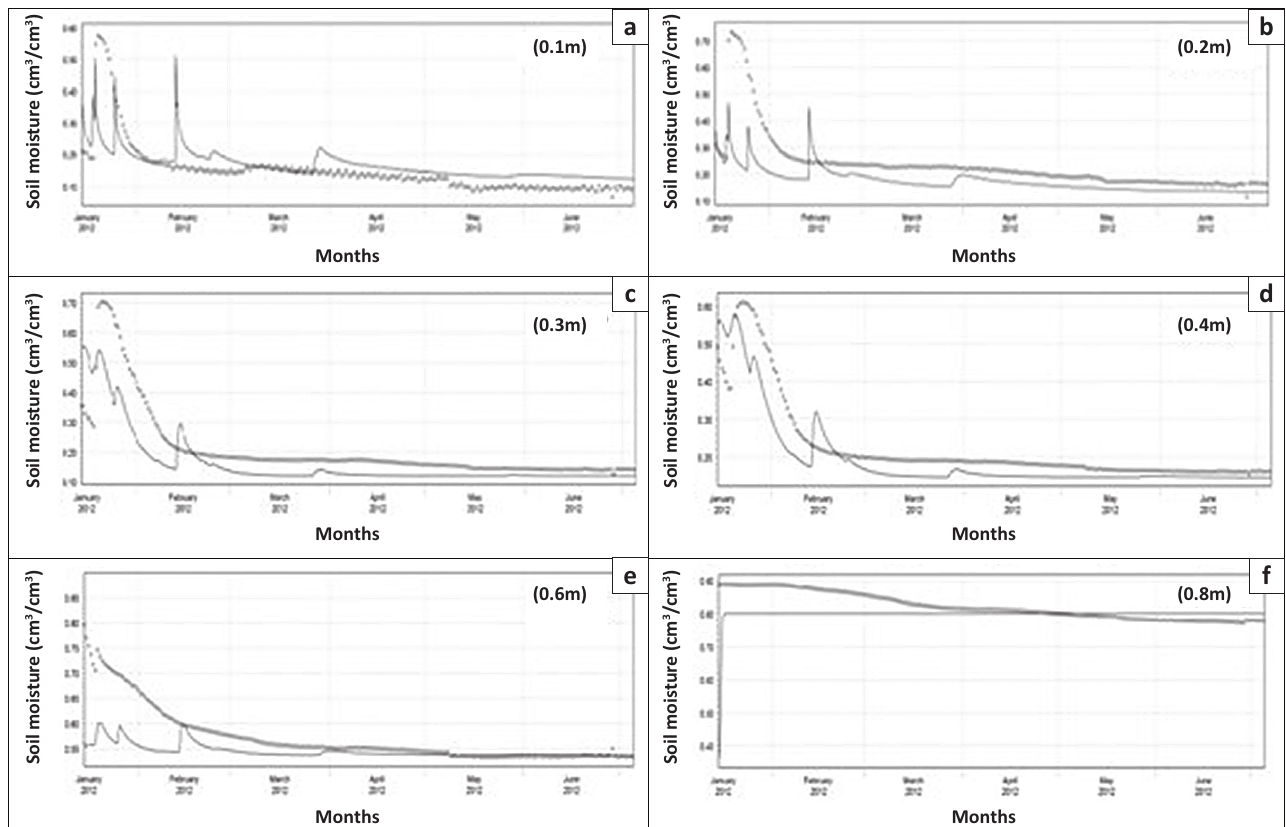
FIGURE 4: (a–f) Observed (dotted lines) versus simulated (solid line) soil moisture for probe